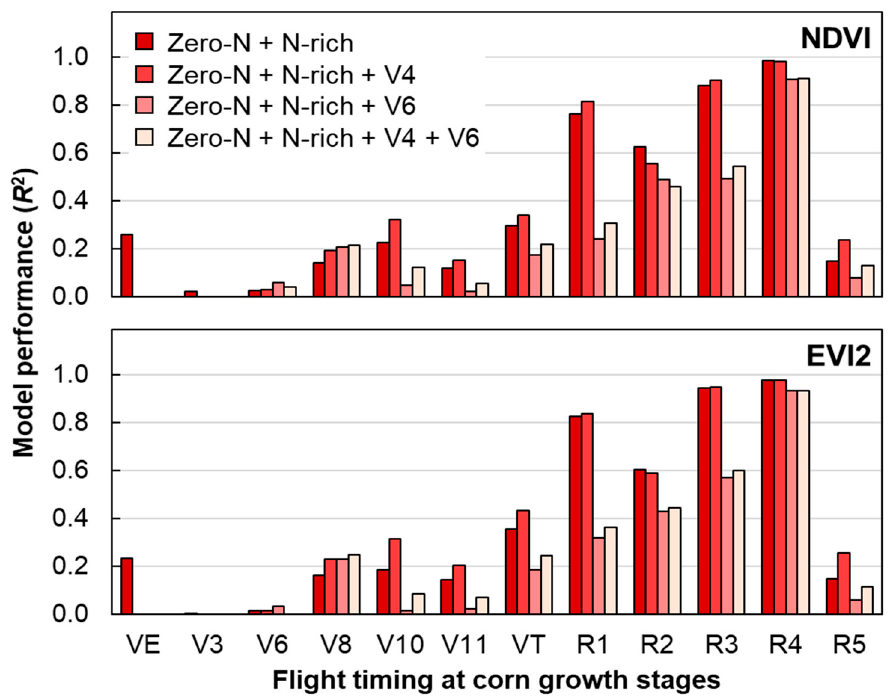
Figure 6. Corn yield estimation model performance of selected vegetation indices and selected sidedress treatment combinations from the UAS images obtained throughout the growing season of 2019.